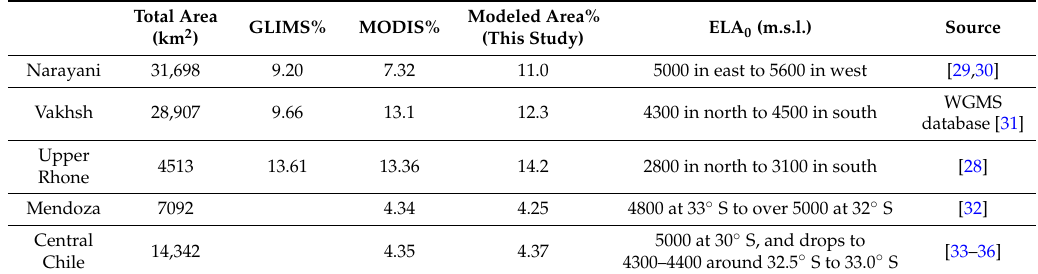
Table 2. The calculated area of glaciers using GLIMS, MODIS, and modeled glacier area in this study. Total Area (km 2 ) Modeled Area% Total Area GLIMS% MODIS% ELA 0 (m.s.l.) (km 2 ) (This Study)